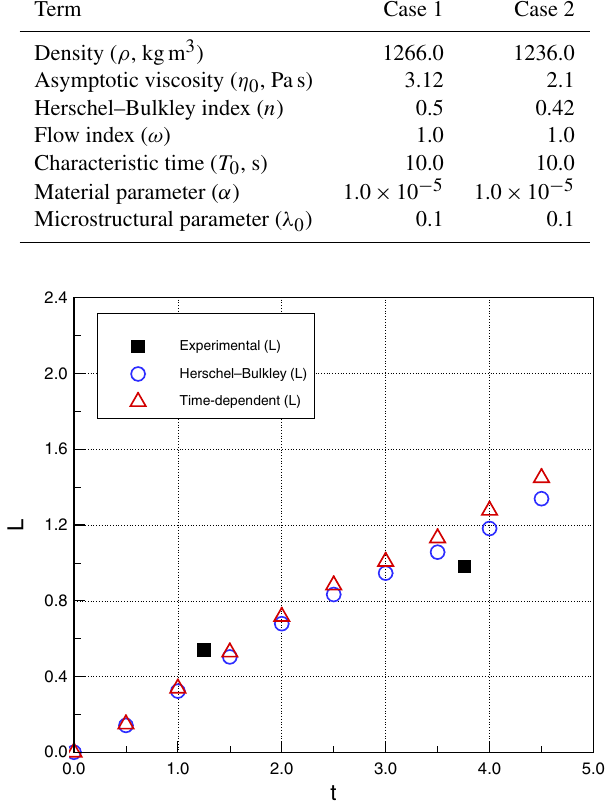
Figure 15. Subaqueous debris case 1: run-out distance ( L , m) as a function of simulation time ( t ,